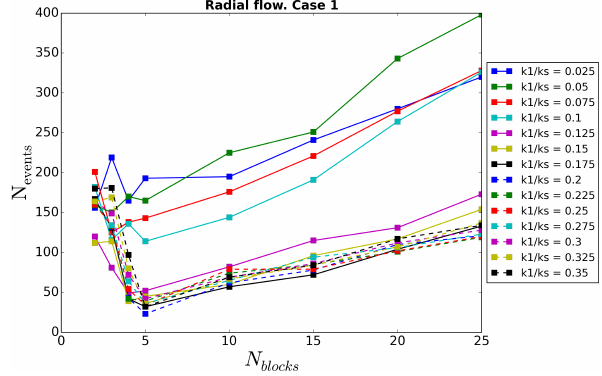
Figure 4. Cumulative number of events vs. number of